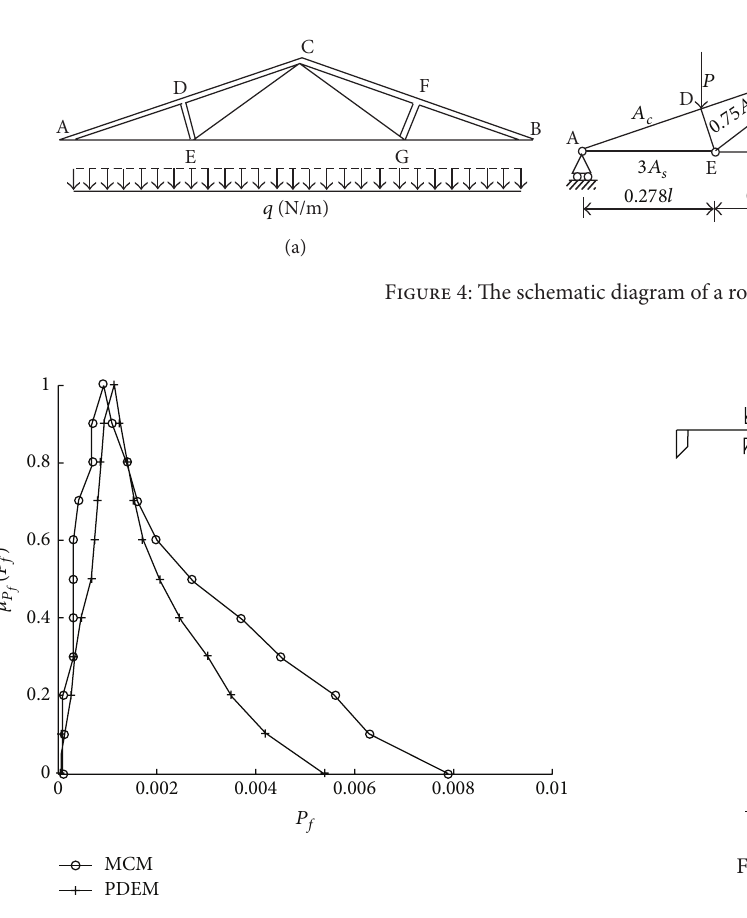
Figure 5: The membership function of 𝑃 𝑓 of the roof trussstructure.